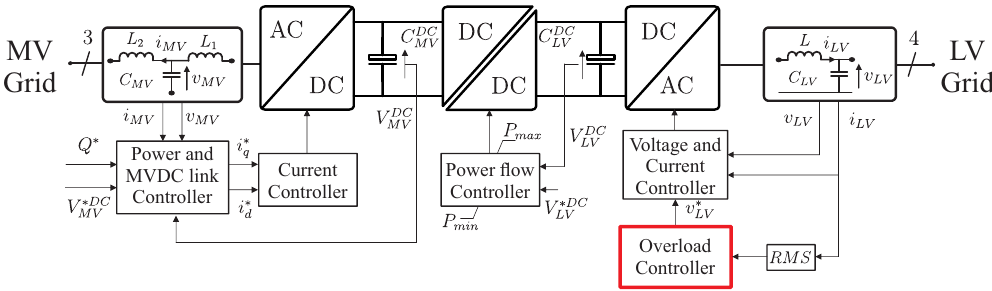
Figure 2. Smart transformer control scheme and proposed controller to avoid overload condition (red square). RMS: root mean